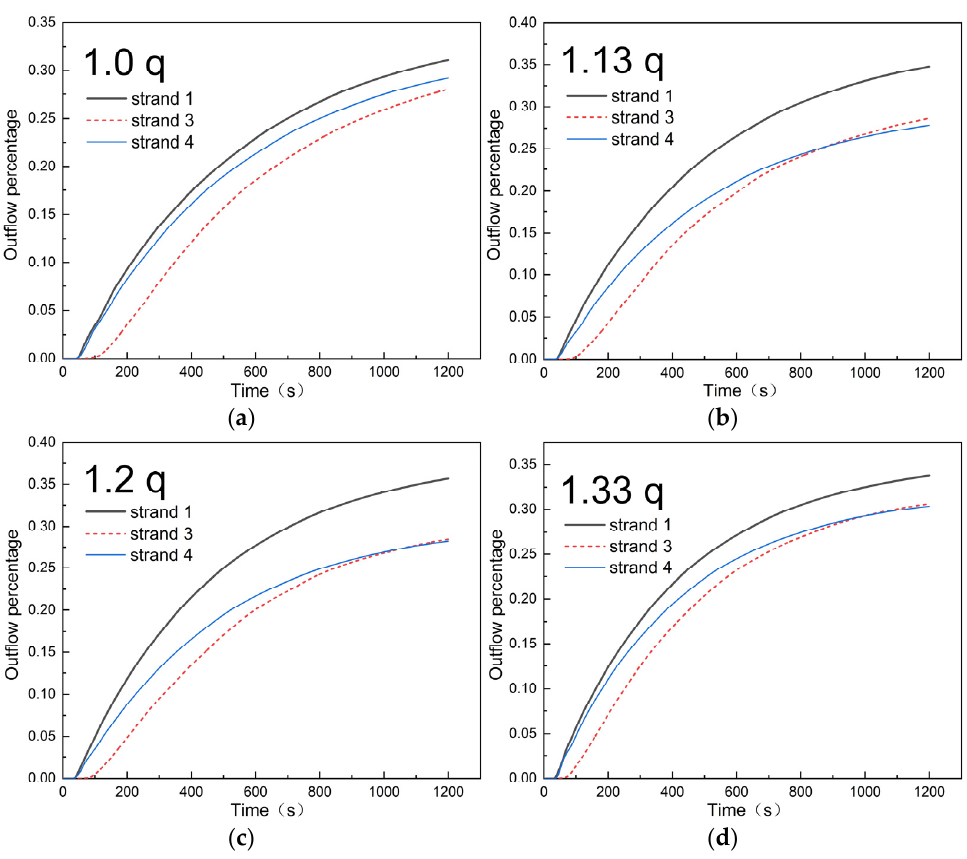
Figure 19. Outflow percentage curve of the u-shaped weir tundish with uniform increasing casting flow rate under strand 2 blockage condition: ( a ) 1.0 q, ( b ) 1.13 q, ( c ) 1.20 q, ( d ) 1.33 q.